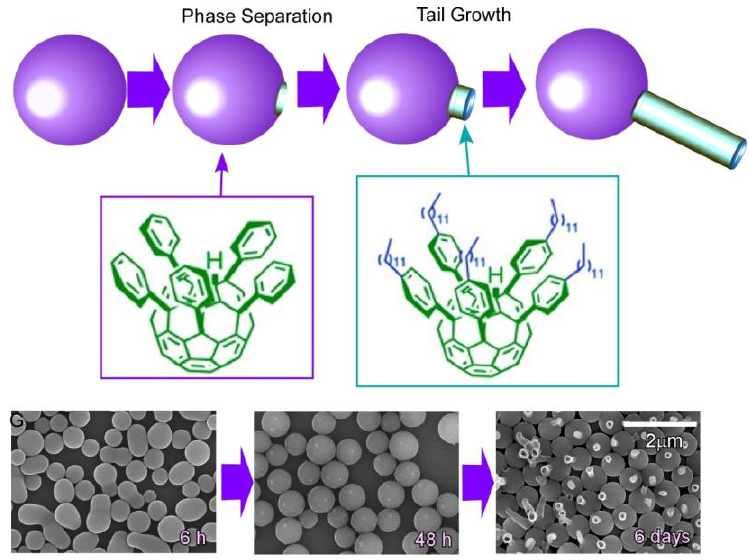
Figure 8. Supramolecular differentiation with the time-programmed regulation of multiple assembling